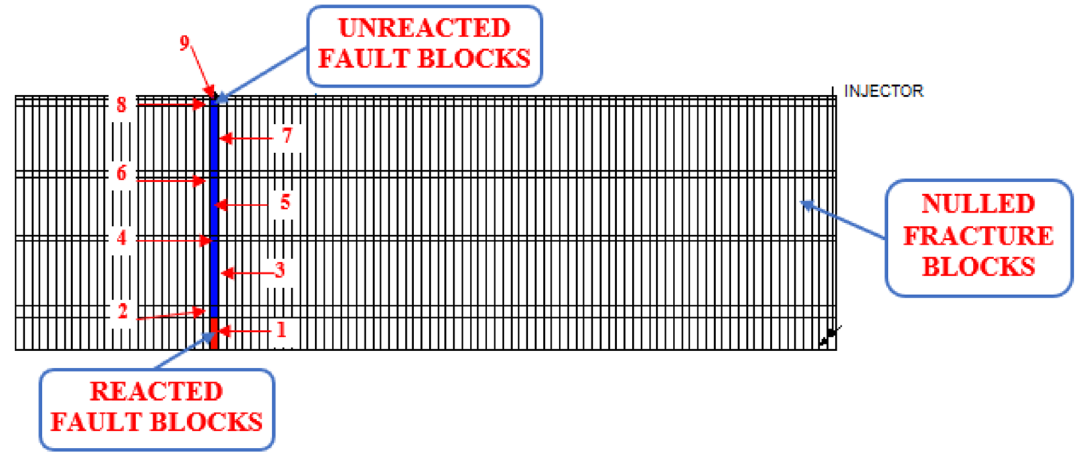
Fig. 13 Illustration of fault reactivation and fault-block numbering for referencing during discussions on reactivation